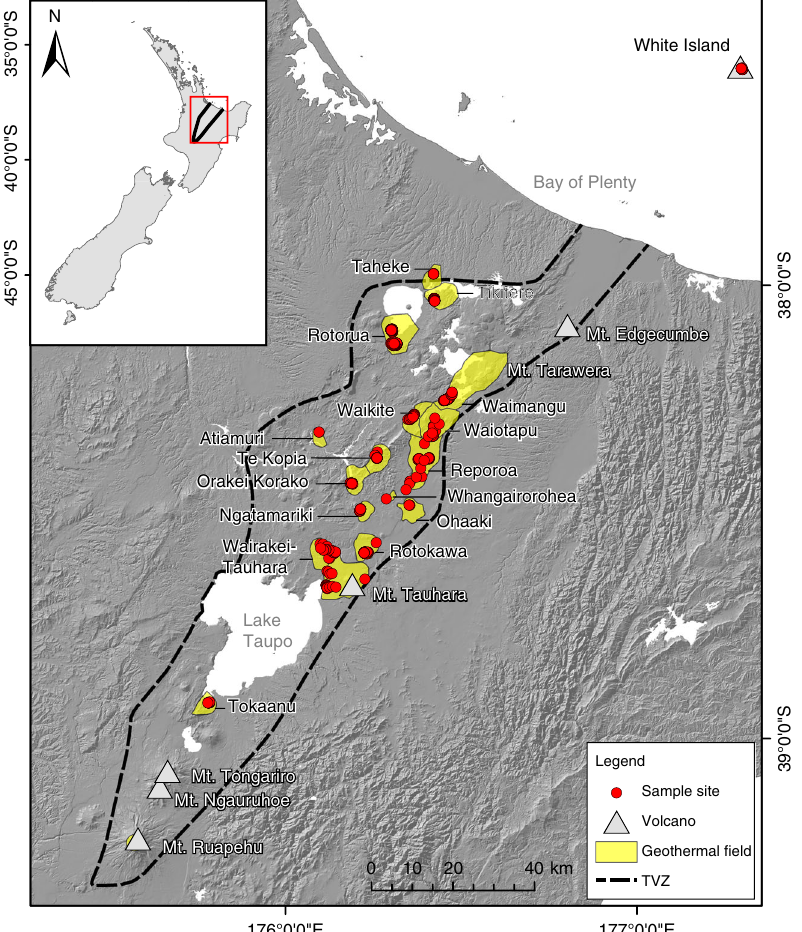
Fig. 1 Map of the Taup ō Volcanic Zone (TVZ), New Zealand. The geothermal fi elds from which samples were collected are presented in yellow. All sampled geothermal springs ( n = 1019) are marked by red circles. The panel insert highlights the location of the TVZ in the central north island of New Zealand. The topographic layers for this map were obtained from Land Information New Zealand (LINZ; CC-BY-4.0) and the TVZ boundary de fi ned using data from Wilson et al.